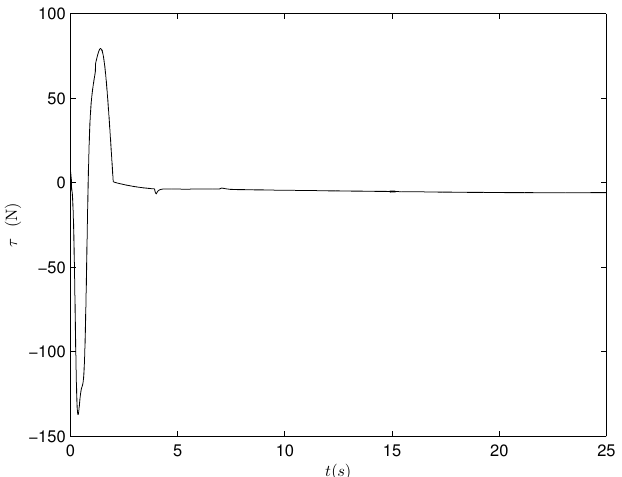
Figure 5. Control input (output feedback barrier adaptive control).